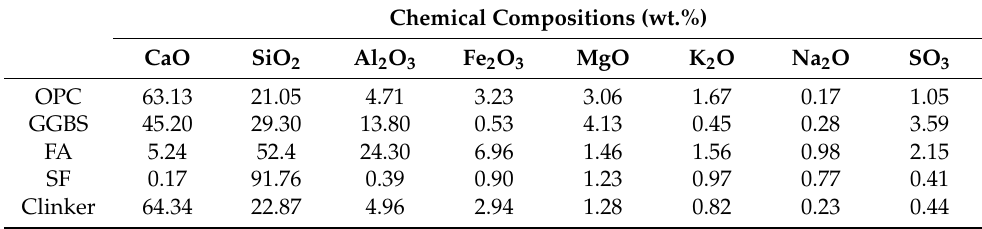
Table 1. Chemical compositions of raw